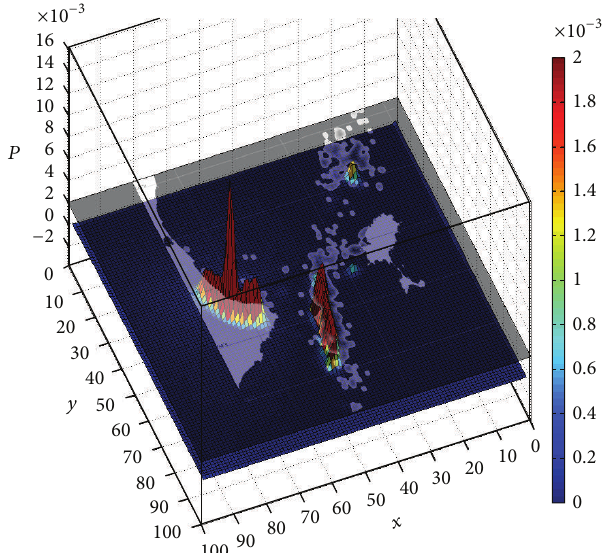
Figure 11: Three-dimensional representation of the probability that a robot is in a particular position at 𝑡 = 168 h. Sampled using the macroscopic model of the swarm with the Fokker-Planck equation. A map for the probability 0.002 where the environment and the state of the spill at 𝑡 = 168 h are represented is added.